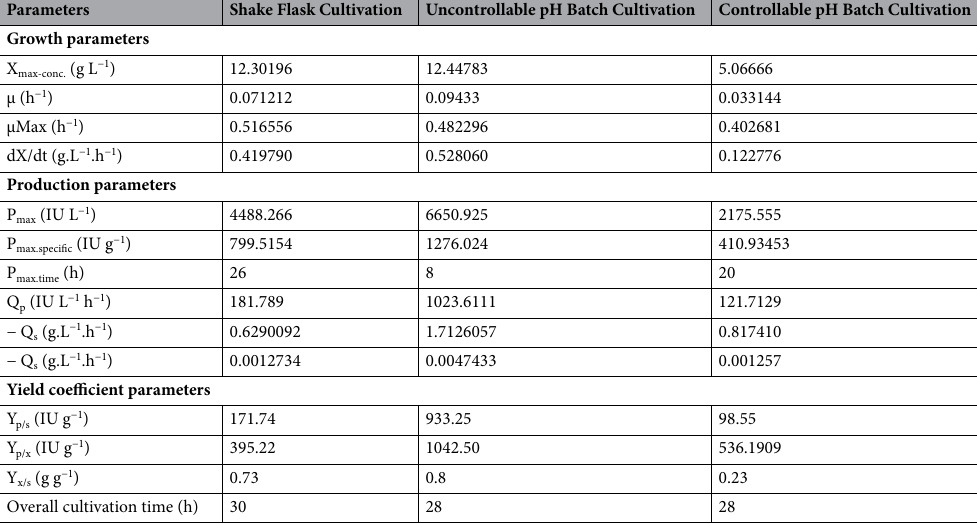
Table 5. Kinetic parameters of cell growth and ALP production by Bacillus paralicheniformis strain APSO as affected by different cultivation strategies. X max-conc. maximal cell dry weight, dx/dt cell growth rate, µ specific growth rate, P max maximal ALP production, P max specific specific productivity, Q p ALP production rate, Q s , substrate consumption rate; Y p/ x U of ALP produced per g biomass, p/s U of ALP produced per g substrate consumed, Y x/s , g biomass produced per g substrate